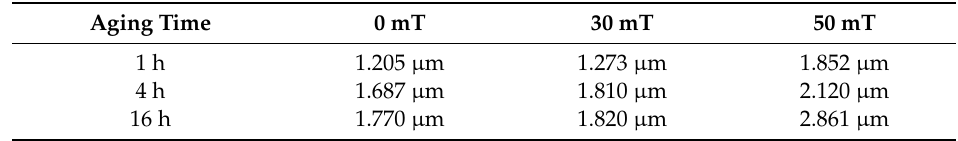
Table 5. The influence of electromagnetic field on the average length of the δ phase after di ff erent aging